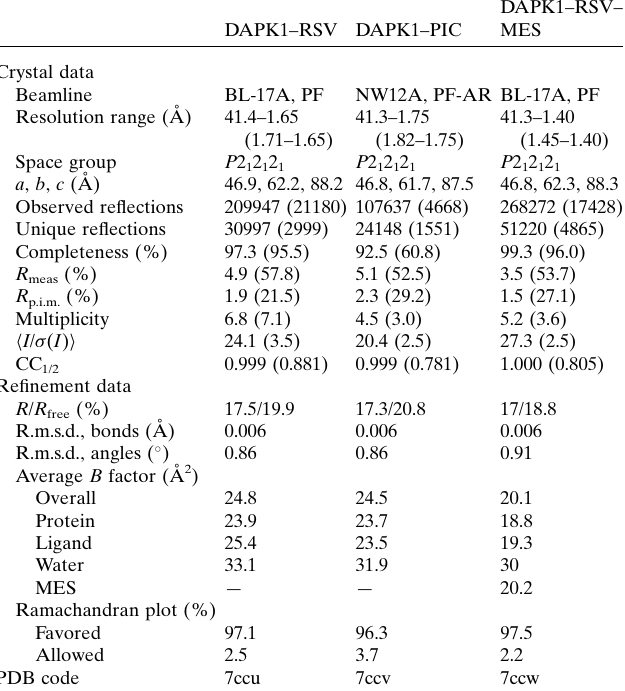
Table 1 Kinetic parameters for the intrinsic ATPase activity of DAPK1 in the absence and presence of RSV.